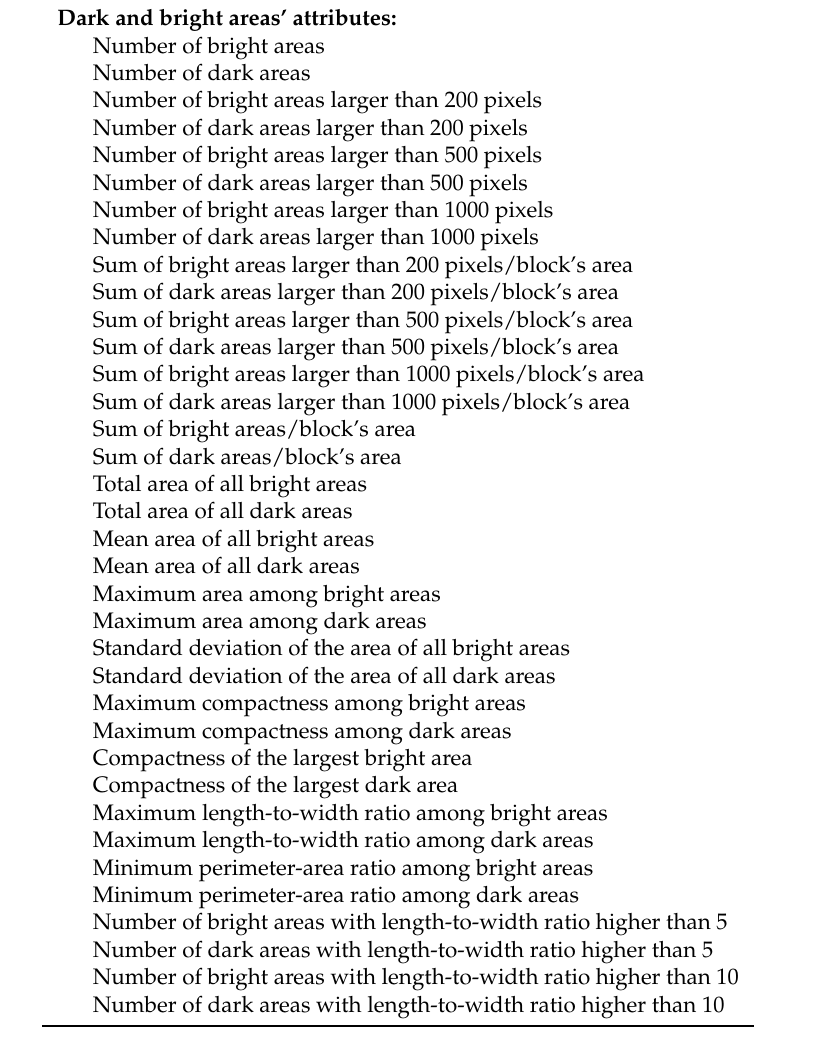
Table 1. Urban blocks attributes computed from the extracted bright and dark areas. Bright and dark areas were extracted by applying threshold operations on the Synthetic Aperture Radar intensity and coherence